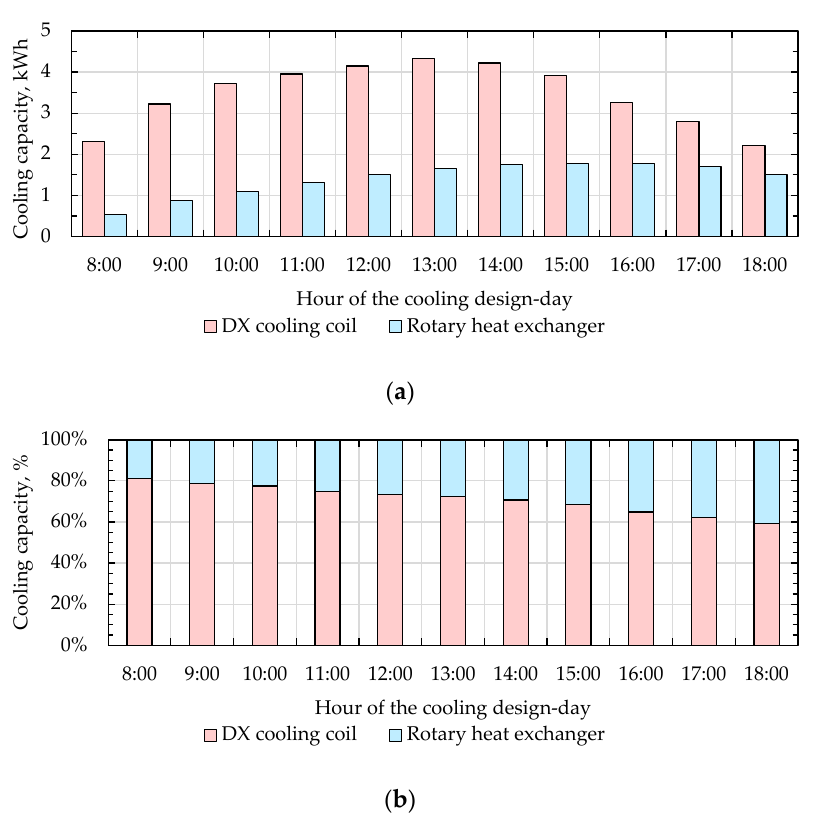
Figure 9. The cooling capacity of System 1: ( a ) the values; ( b ) the share covered by each component.